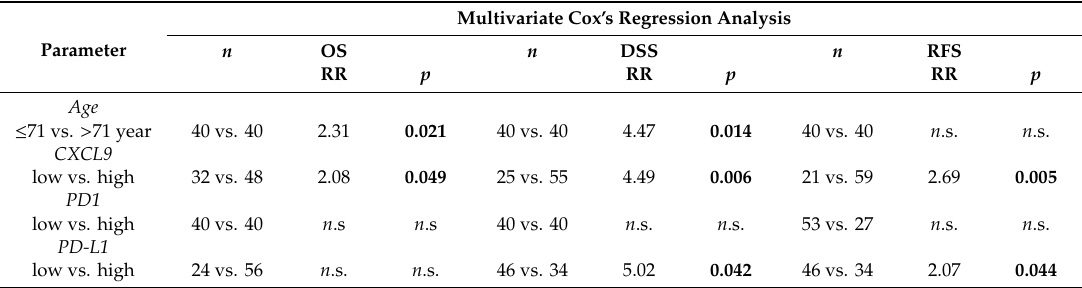
Table 4. Multivariate Cox’s regression analysis for the association of age and CXCL9, PD1 and PD-L1 mRNA with